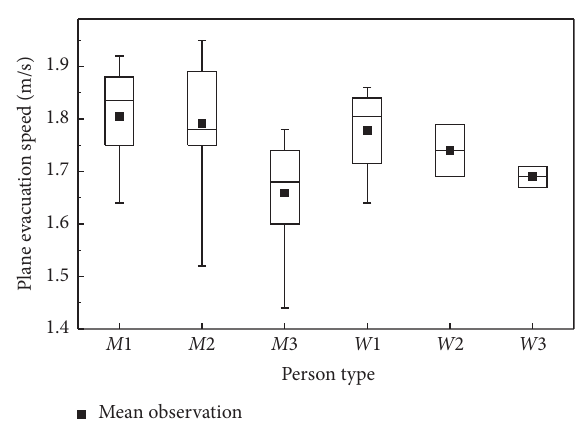
Figure 7: Box figure of plane evacuation speed.